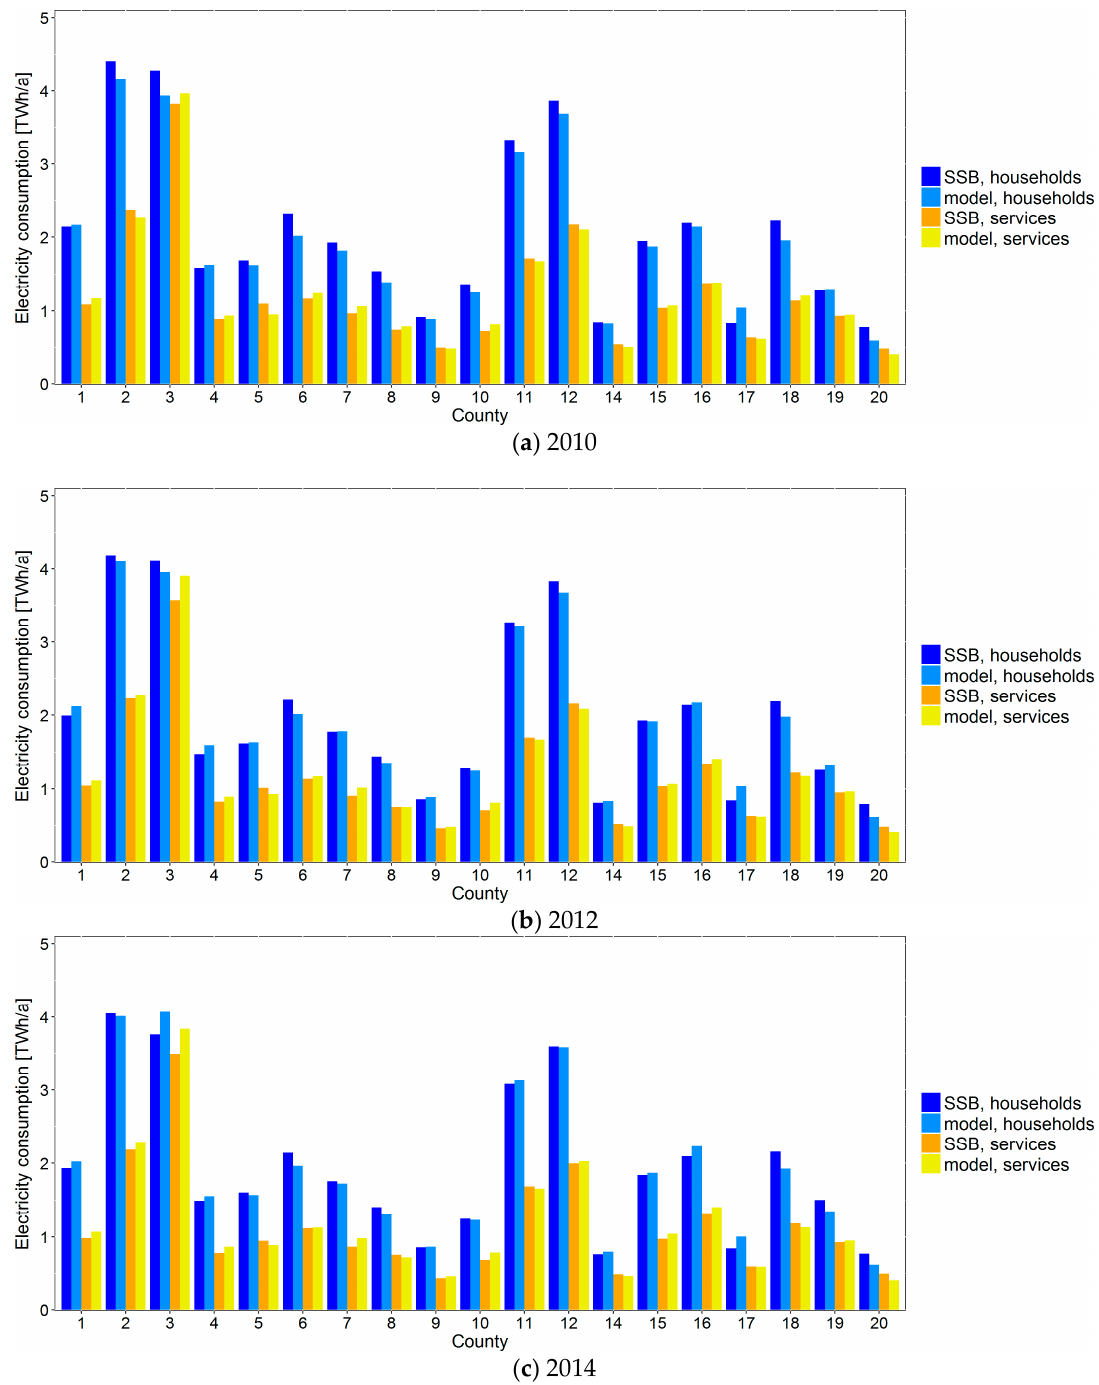
Figure 7. Modeled and metered (SSB [45,46]) electricity consumption in household and service sectors per county, 2010, 2012 and 2014.